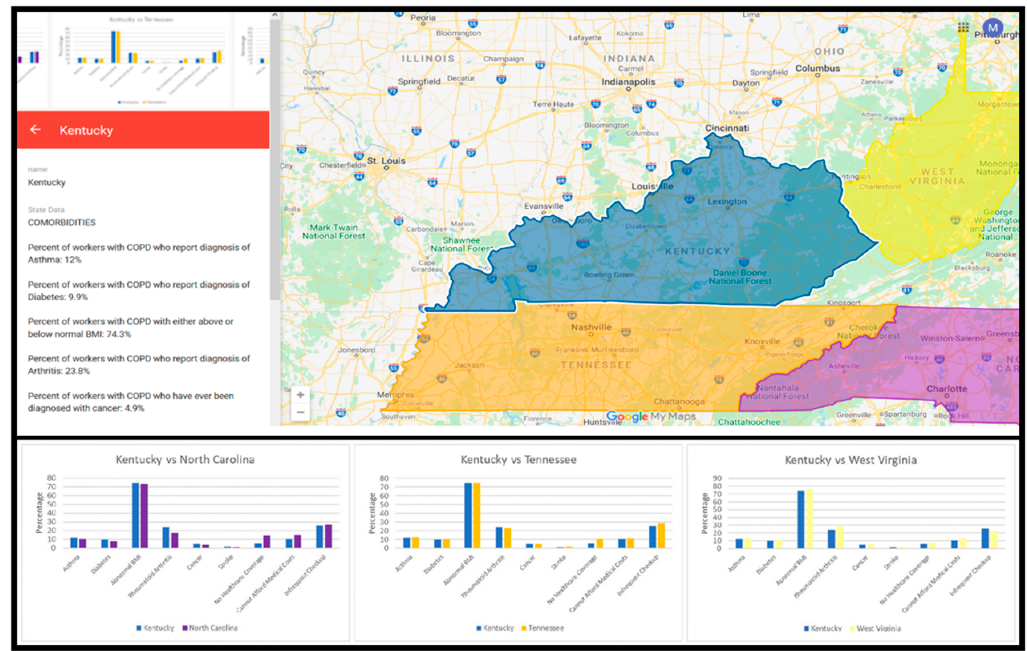
Figure 5. Google Map visualization depicting percentage of employed KY adults with COPD who reported comorbidities. Kentucky is selected on the Google Map. The percentage of BRFSS respondents with comorbid health conditions and health care access variables are displayed on the left side. Bar charts can be selected by clicking the upper right-hand corner to open pairwise state comparisons describing the percentage of KY respondents reporting each comorbidity as compared to respondents in each of the other three U.S. states (NC, TN, and WV).